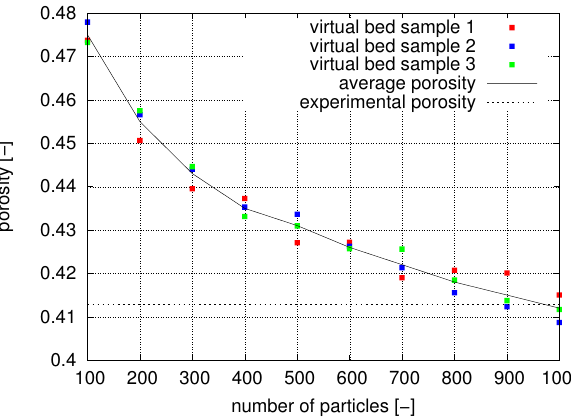
Figure 6. Relationship between the number of particles and the bed